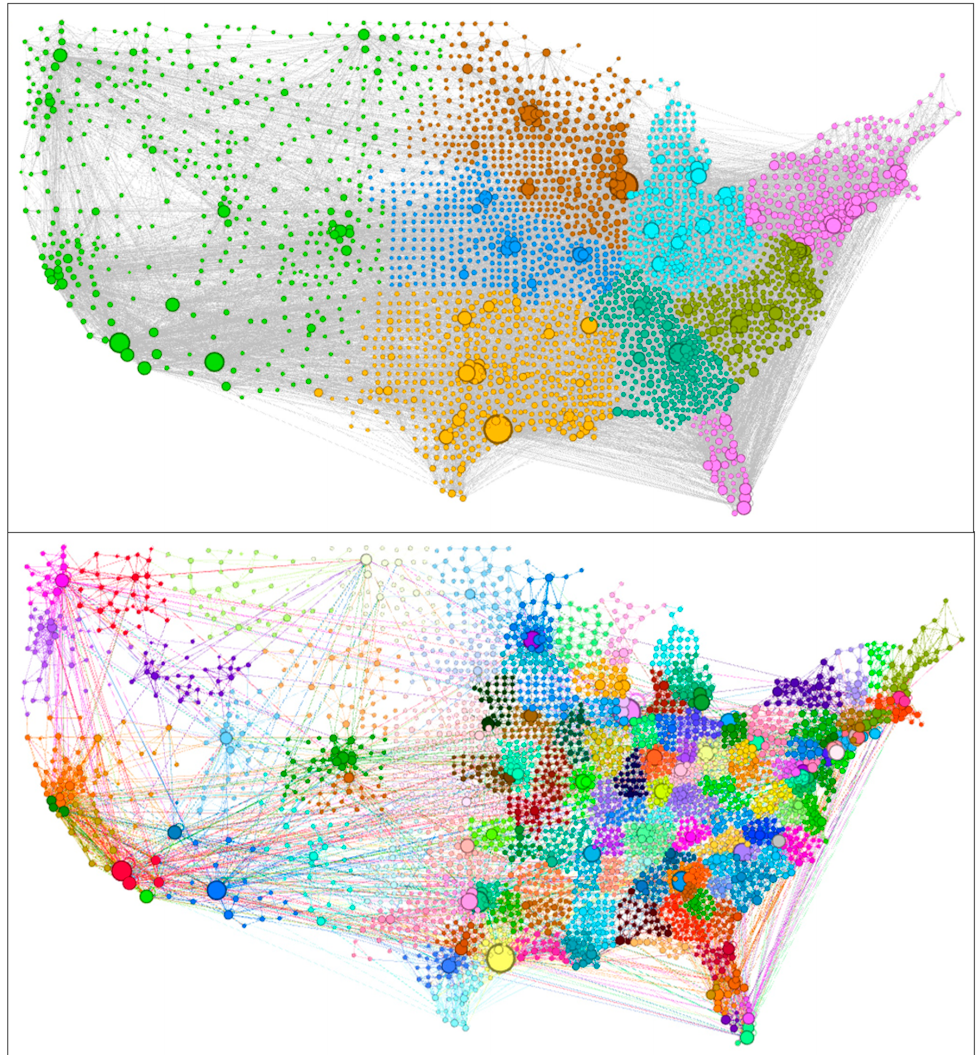
Figure 3. Community Detection Analysis for County Network Weighted by Inter-County Commuting Flows (Top: Resolution: 1.00; Modularity: 0.556; # of Communities: 8; Bottom: Resolution: 0.05; Modularity: 0.197; # of Communities: 157).